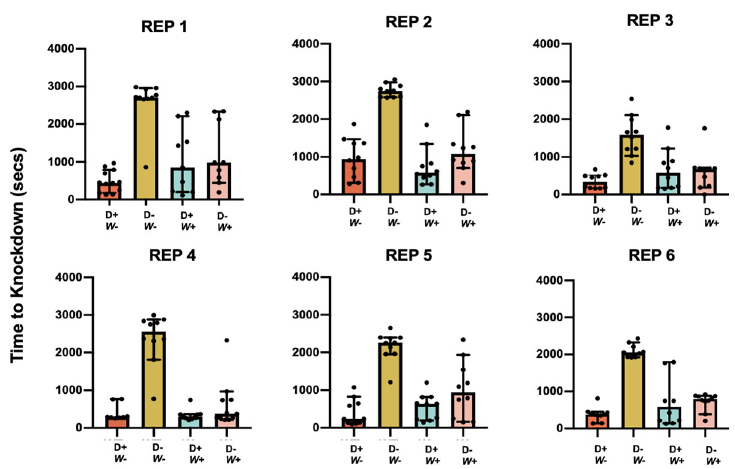
Fig 4. Impact of dual microbe infection on mosquito thermal sensitivity. The effect of Wolbachia and DENV infection on knockdown time (seconds) across 6 temporal replicates, each containing 10 mosquitoes per the 4 treatment combinations. Box plots represent individual replicate medians and confidence intervals for wildtype infected (D+/W-) and uninfected (D-/W-) mosquitoes, along with Wolbachia infected ( W +) and uninfected ( W - ) individuals. Key Tukey’s post hoc comparisons for each replicate are described in the text and S5 Table. In brief, the effects of DENV and Wolbachia individually were significant in all 6 replicates, as was the comparison between the single infection (DENV) and the double infection (DENV and Wolbachia